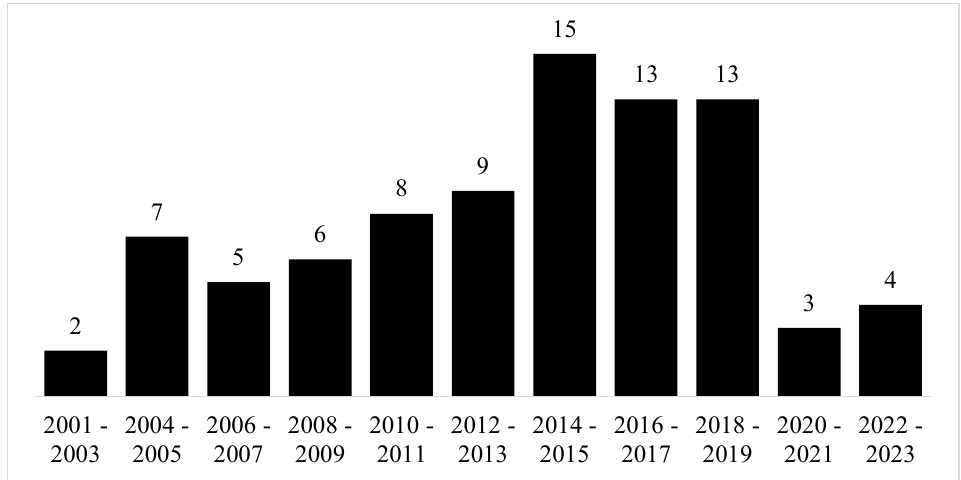
Figure 6. The number of reviewed articles by years.